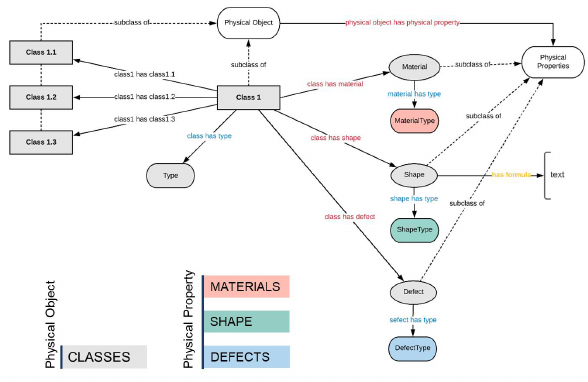
Figure 3 . The conceptualization schema concerning the Phisycal Object and the Physical Property proposal